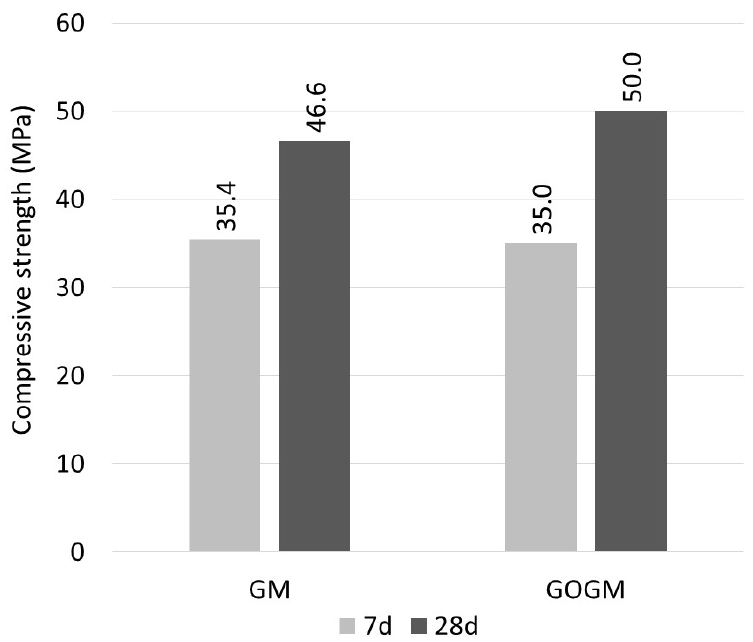
Figure 3. Compressive strength of geopolymer mortar .